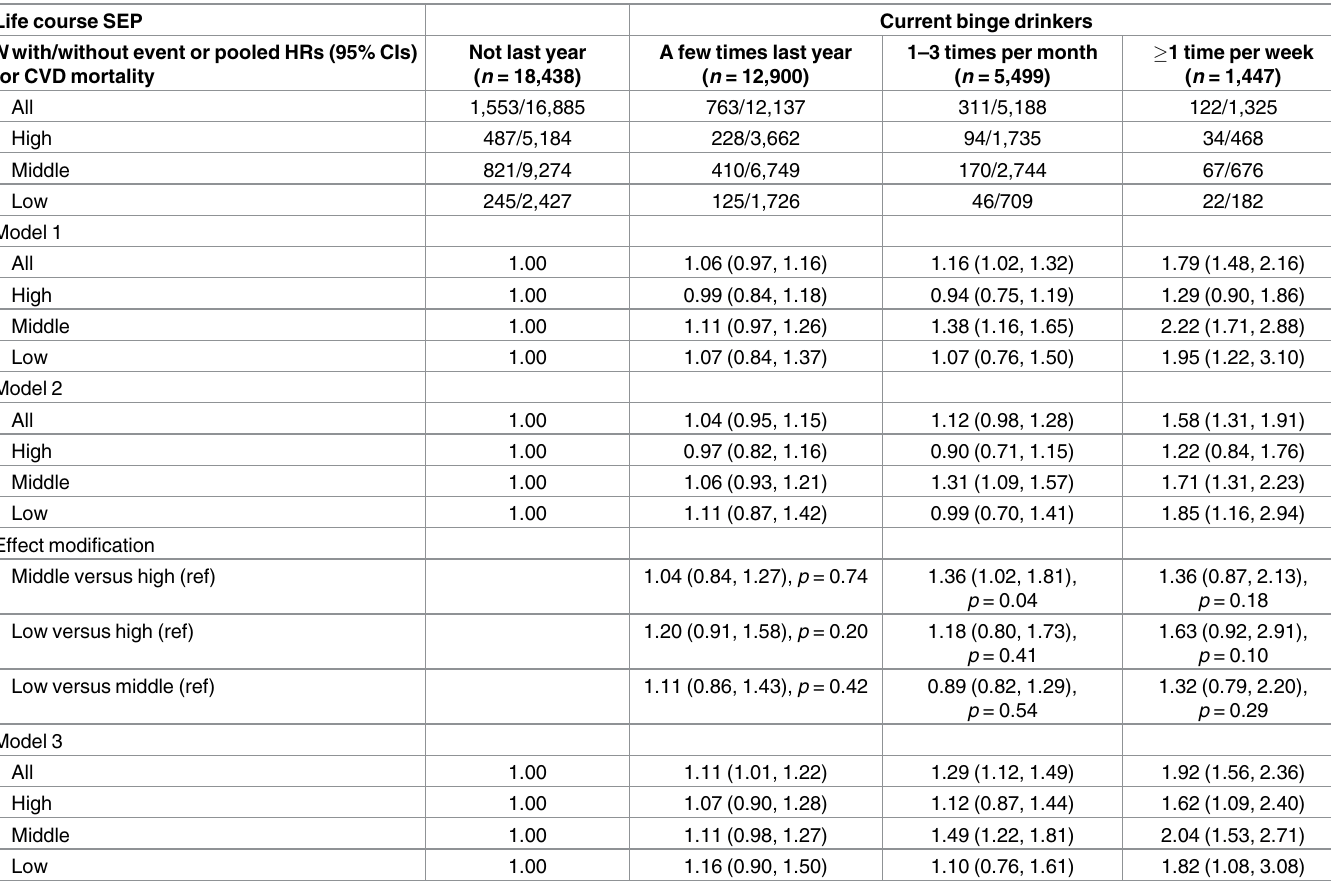
Table 3. Cardiovascular mortality according to heavy drinking episodes using multiple imputation ( n =